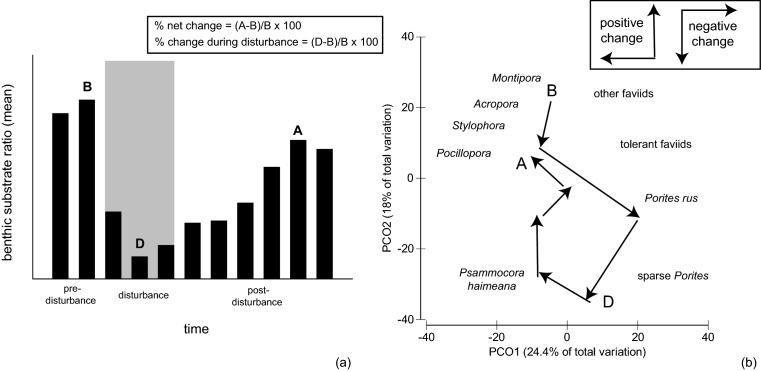
Methods used to calculate the percent decline and net change in (a) the benthic substrate ratio and (b) multivariate measures of the coral assemblages.B, D, A – before, during, and after the disturbance period, respectively. Percent declines were calculated by taking the difference between the minimum and maximum values during and before the disturbance period, and dividing by the pre-disturbance values. Net change values were calculated by taking the difference between maximum values before and after the disturbance period. Values for coral assemblages were calculated based upon their vector magnitude from the origin (0,0), with positive values given for PCO movement towards Acropora, Montipora, and Pocillopora assemblages, and negative values for PCO movement towards tolerant faviids and sparse Porites. See methods and Figure 6 for a better description of the corals depicted on the PCO plot.